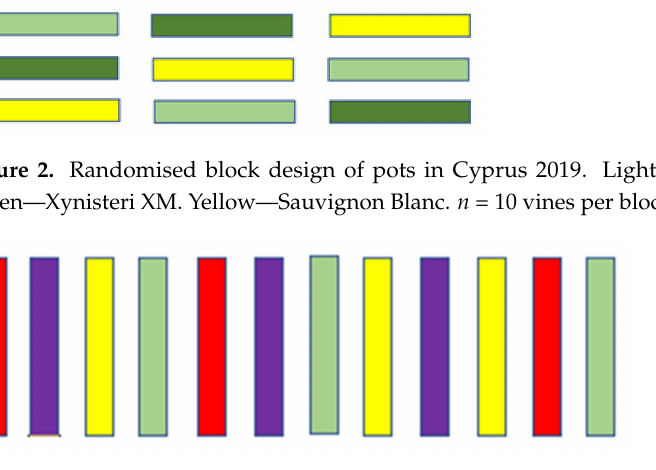
Figure 3. Randomised block design of pots in South Australia in 2020/2021. Green—Xynisteri. Yellow—Sauvignon Blanc. Red—Maratheftiko. Purple—Shiraz. n = 7 vines per